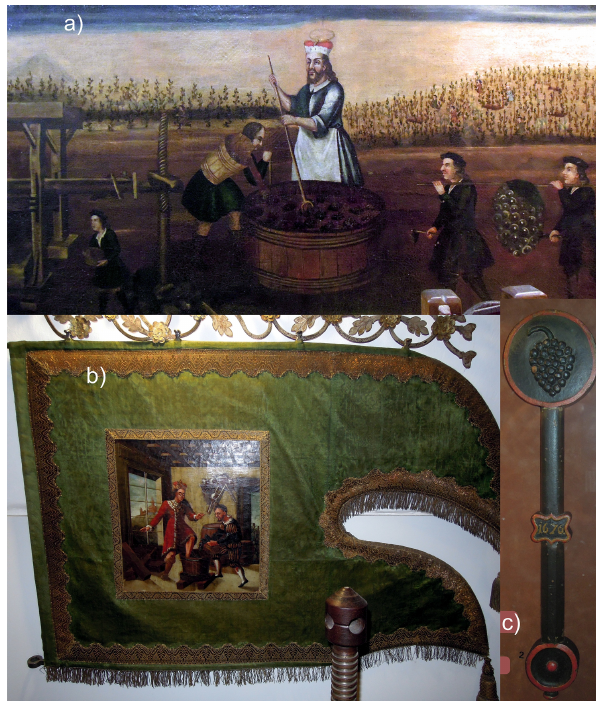
Figure 2. (a) Oil painting of St. Wenceslas in a vineyard, 18th cen- tury; (b) flag of the guild of wine cultivators, 1762; (c) insignia of the guild of wine cultivators, 1676 (from the collections of the Mˇel- ník Regional Museum; photo M.